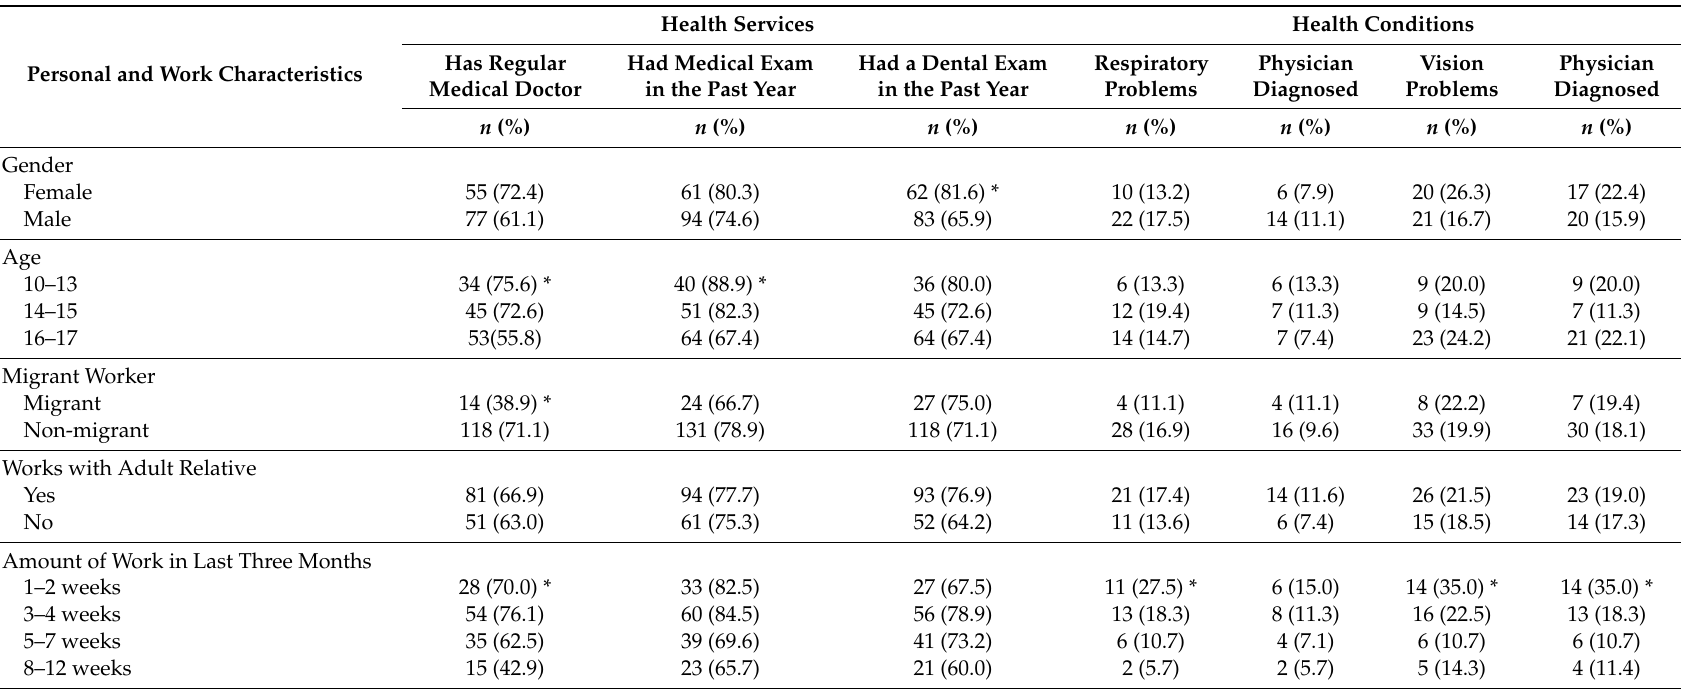
Table 3. Association of personal and work characteristics with health characteristics for North Carolina Latinx child farmworkers,